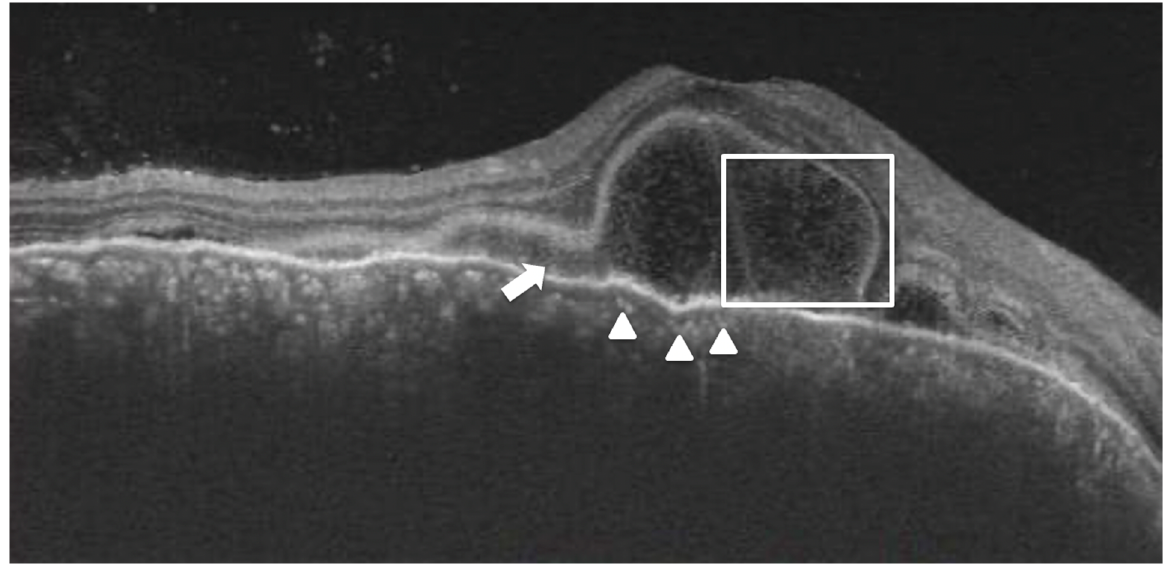
Figure 4. A 32-year-old lady with a diagnosis of acute Vogt-Koyanagi-Harada disease. The right eye shows bacillary layer detachment (white box) with subretinal hyperre fl ective material (white arrow) and choroidal hyperre fl ective dots (white arrowhead).